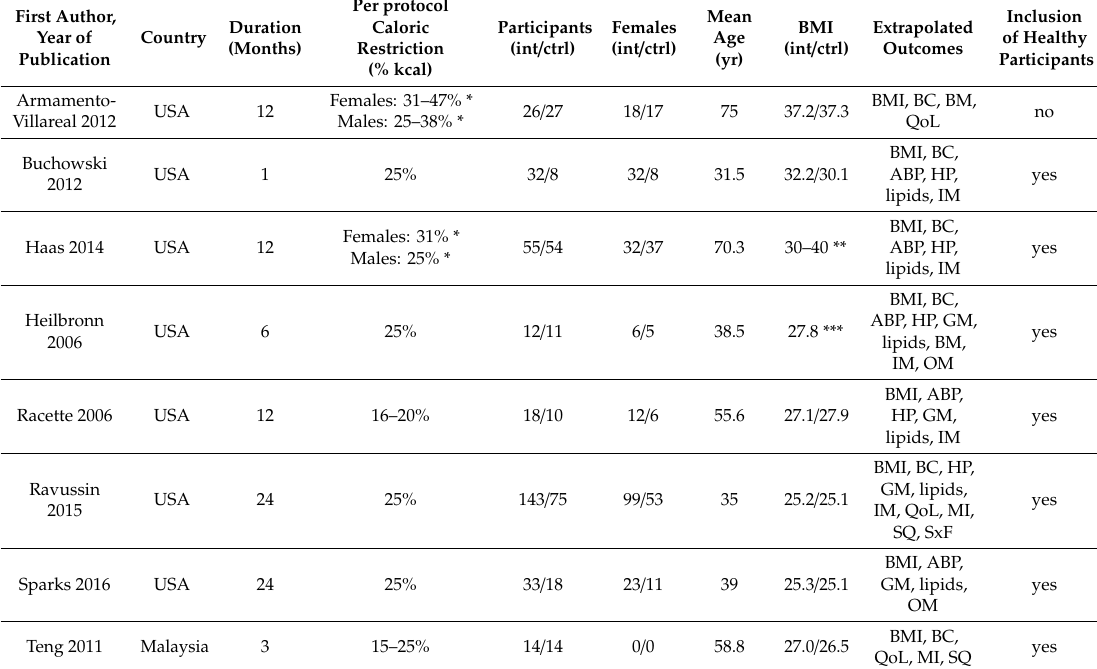
Table 1. Characteristics of included studies. Main baseline characteristics of randomized controlled trials (RCTs) included in systematic review (SR) (further details are reported in Table S3 Table of